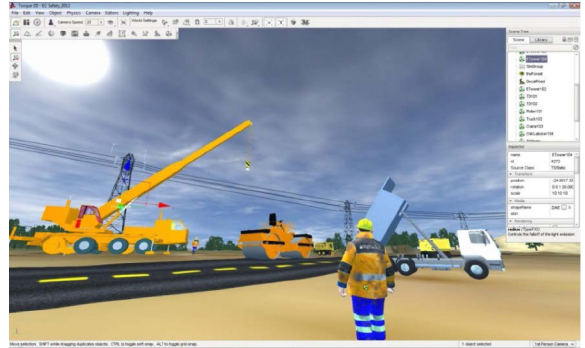
Fig. 4. Prototype application